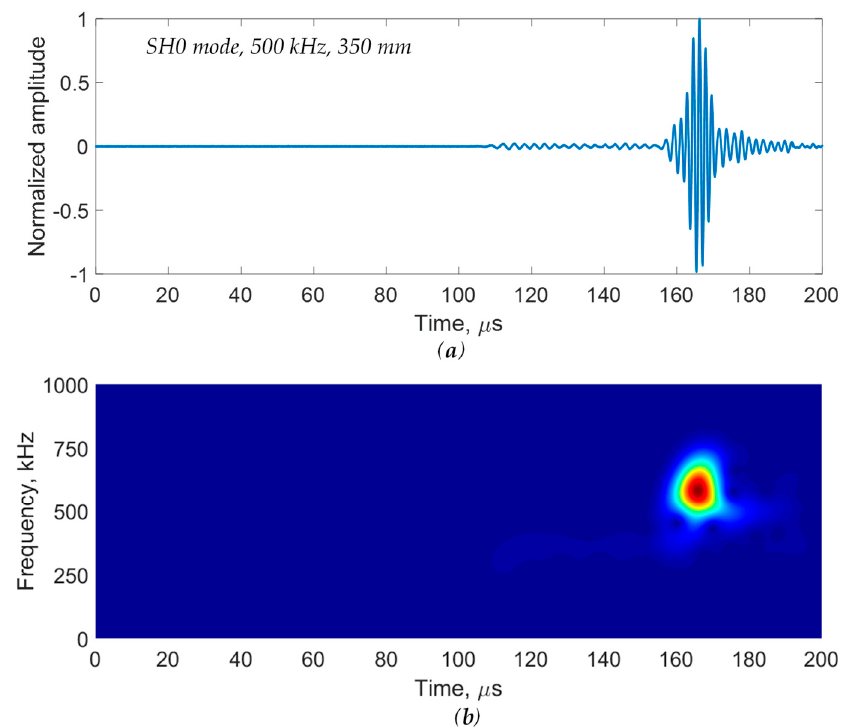
Figure 21. Response signal at a 350-mm distance for the SH0 mode excitation at 500 kHz in the 3-mm quasi-isotropic composite plate: ( a ) time-domain signal; ( b ) the short-time Fourier transform (STFT) spectrogram.